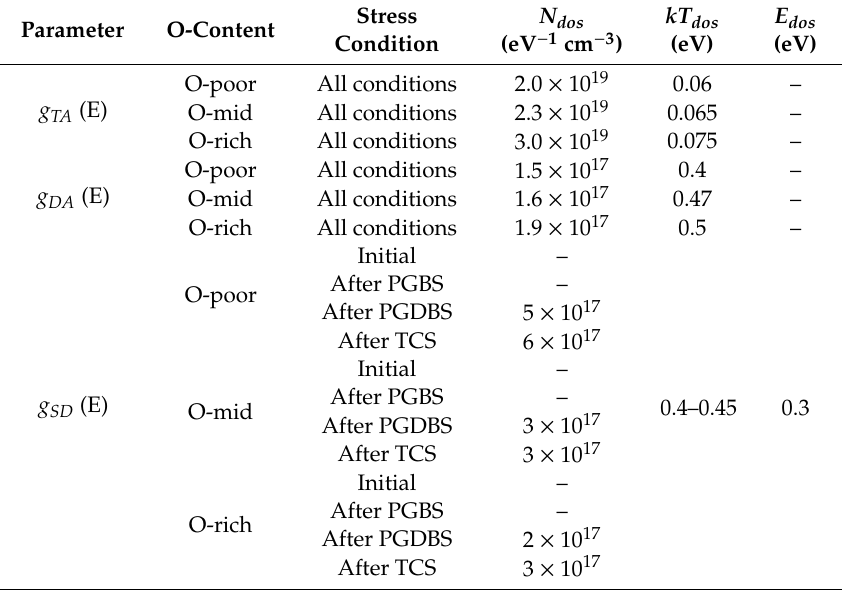
Table 2. Extracted DOS parameters (initial and after PGBS, PGDBS, and